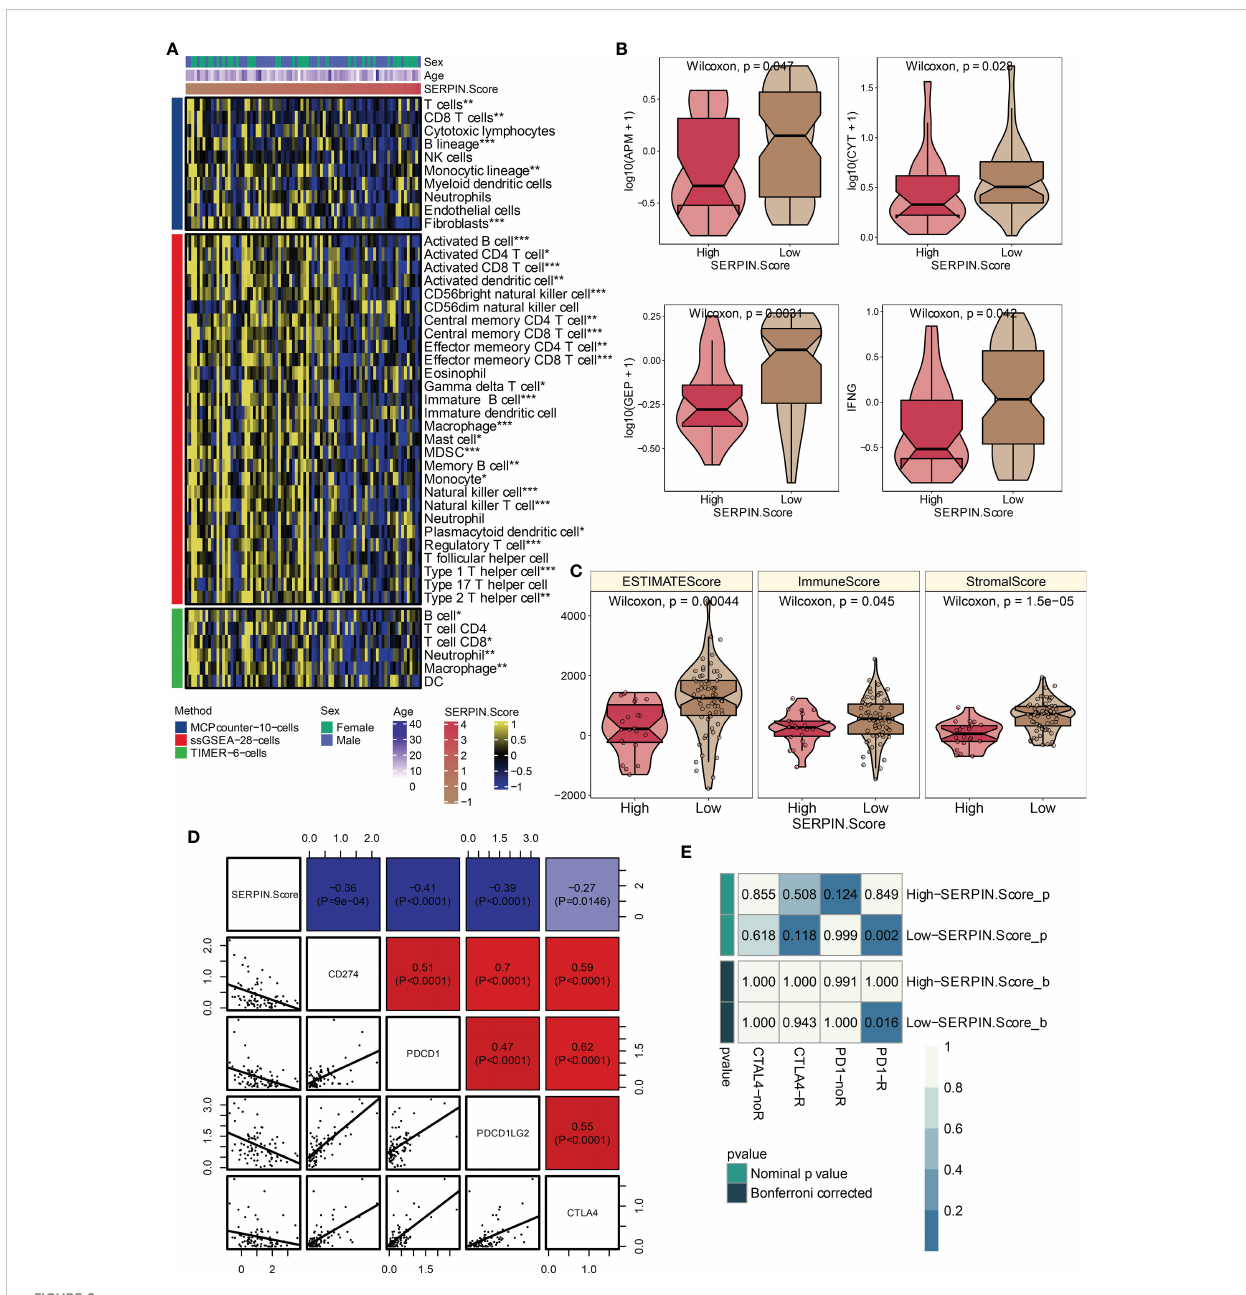
FIGURE 8 Immune characteristics of the SERPINH1-related score. (A) The correlation between the SERPINH1-related score and immune in fi ltrating cells. (B) APM, CYT, GEP, and IFN- g in the two SERPINH1-related score-strati fi ed groups. (C) ESTIMATE, Immune, and Stromal scores in the two SERPINH1-related score-strati fi ed groups. (D) The correlation between the SERPINH1-related score and immune checkpoints. (E) TIDE-based immunotherapy prediction of the SERPINH1-related score. *P<0.05; **P<0.01;